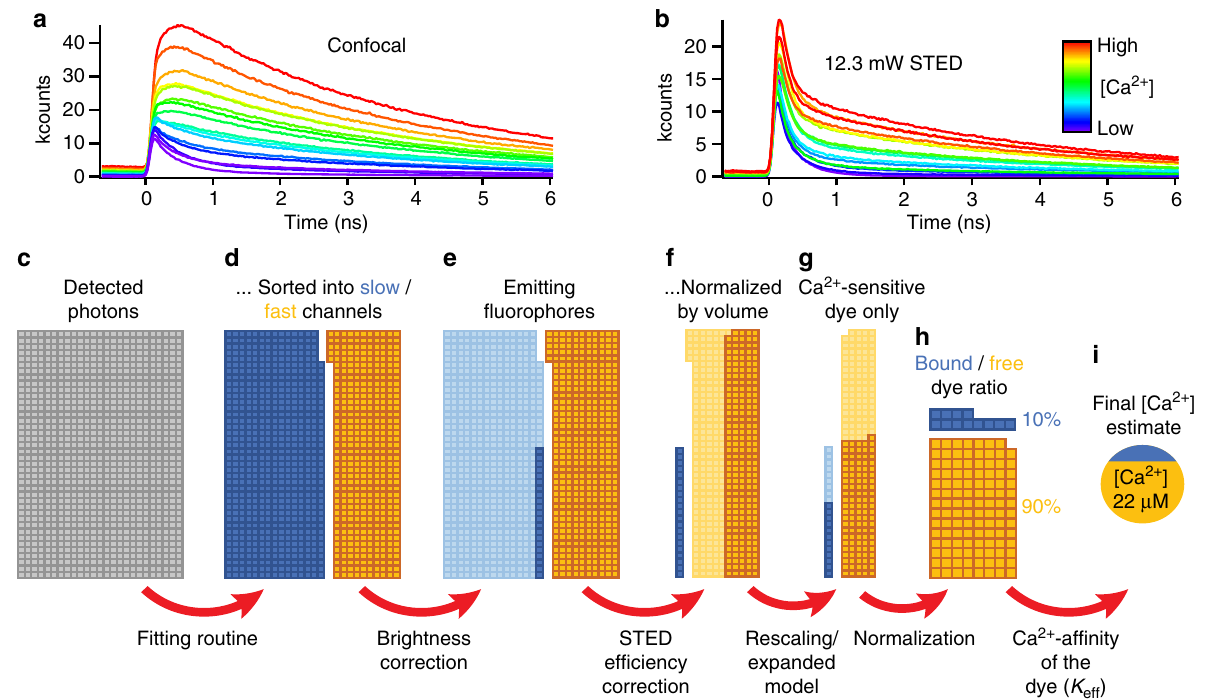
Fig. 7 Calculation of [Ca 2+ ] from measured photons by application of correction factors. a Time-correlated single photon counting (TCSPC) reveals